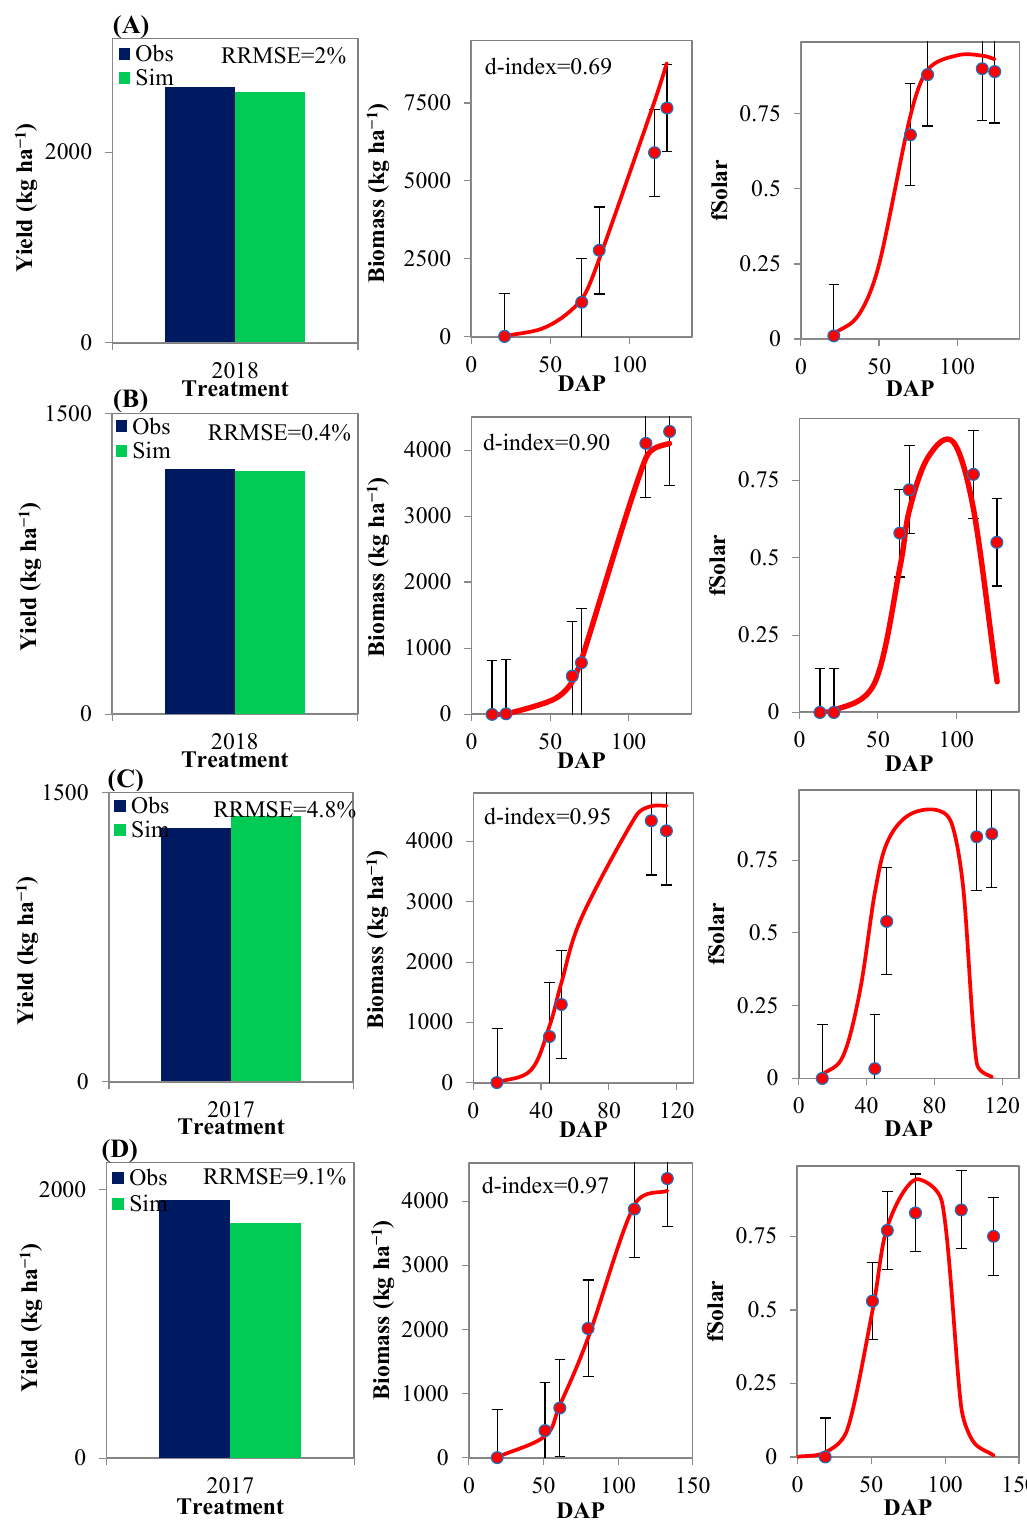
Figure 4. Evaluation of simulated (Sim) and observed (Obs) yield, biomass and fSolar as a function of DAP for oilseed flax cultivar Longya Hybrid No. 1 grown in Dingxi ( A ); Baxuan No. 3 grown in Zhangjiakou ( B ); Longya Hybrid No. 1 grown in Wulanchabu ( C ); and Zhangya No. 2 grown in Datong ( D ). RRMSE—relative root mean